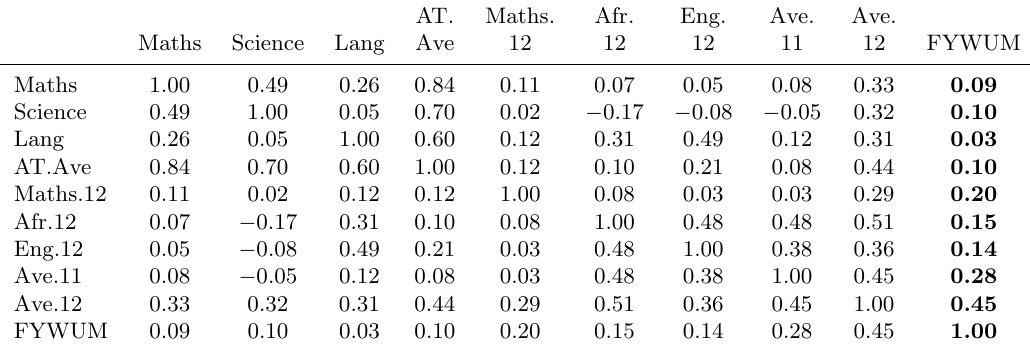
Table 9: Inter-correlations among the Test Battery 1 variables – 1999 [Critical r = 0 . 18 (5% significance level), 0.26 (1% significance level)].